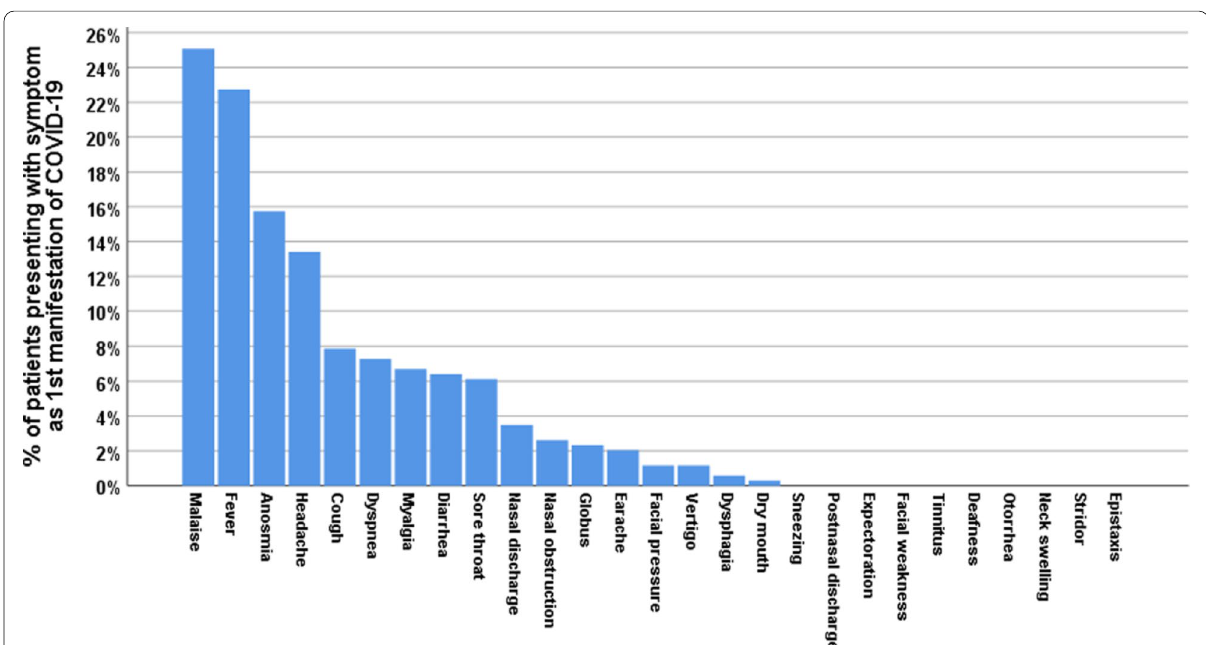
Fig. 2 Percentage of patients presenting with various symptoms (ORL, non-ORL) as first manifestation of COVID-19